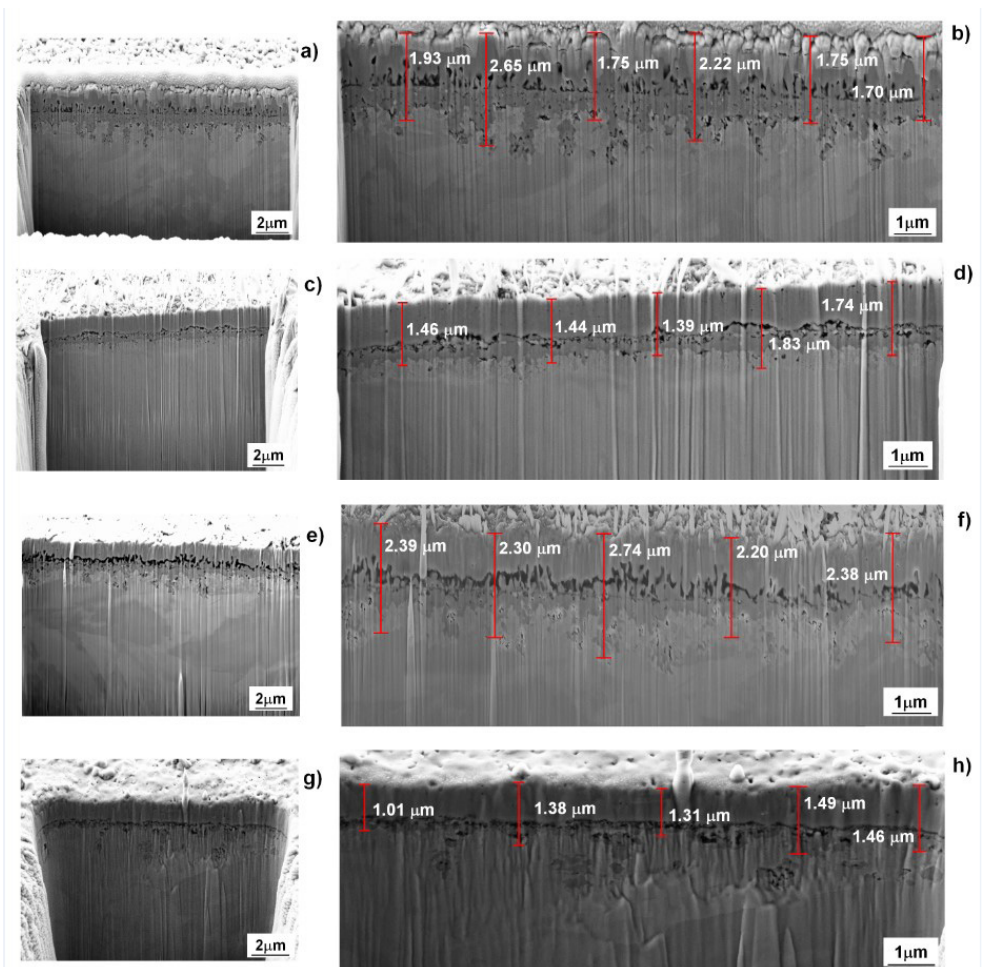
Figure 13. FE-SEM cross-section micrographs though the oxide layer produced using in air synthetic atmosphere on grade 300 (a,b) and 350 maraging steels (c,d) and O atmosphere on grade 300 (e,f) and 350 maraging steels 2